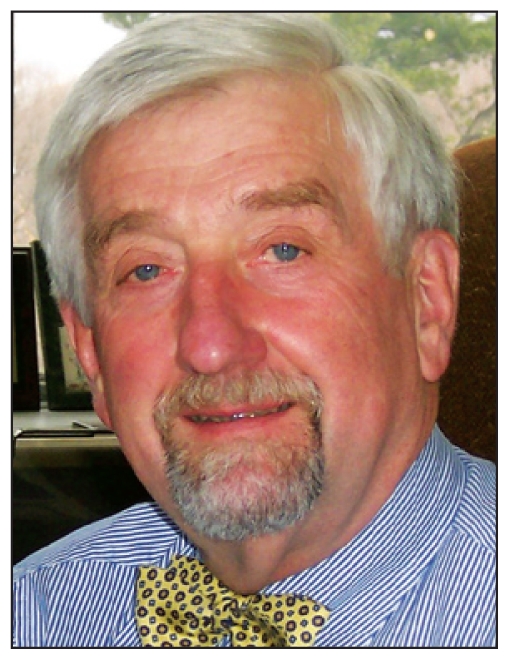
David Carpenter